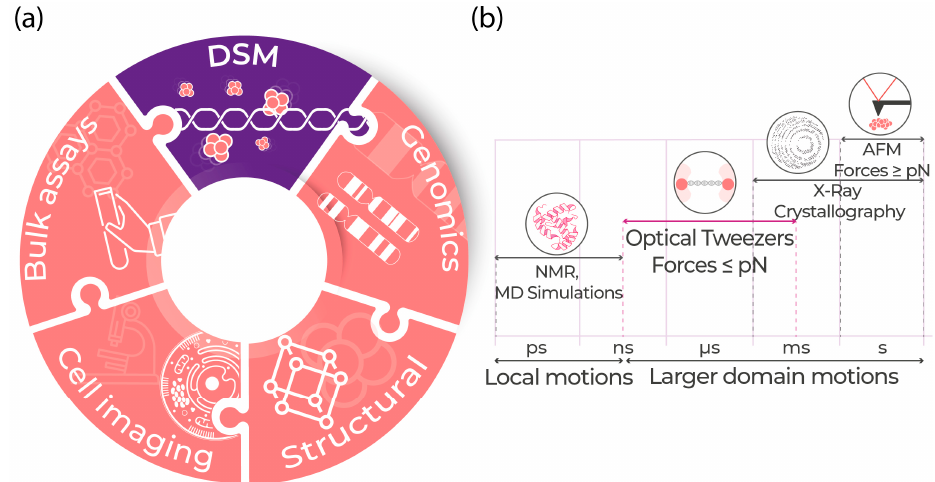
Figure 1. DSM Overview: ( a ) Overview of different domains of biology that together help in understanding the mechanism of actions at each step by determining structure, function, composition, and dynamic information. The field of dynamic single-molecule (DSM) technology aligns closely with other technologies by providing the missing pieces to the puzzle needed to fully understand biological processes (left). ( b ) Among well-known structure-function determination tools, DSM techniques using optical tweezers are positioned within the time scale (of μ s to ms), where the majority of dynamic biomolecular events occur.